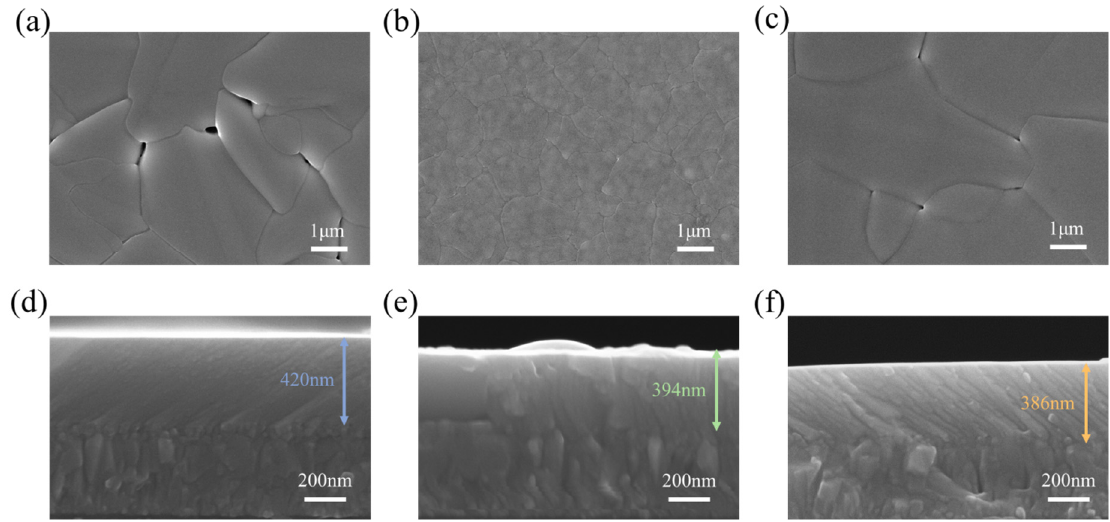
Figure 2. Top-view SEM images of the ( a ) Sb 2 S 3 , ( b ) Sb 2 (S, Se) 3 , and ( c ) Sb 2 S 3 /Sb 2 (S, Se) 3 films deposited on FTO/SnO 2 /CdS substrates. Corresponding cross-sectional SEM images of ( d ) Sb 2 S 3 , ( e ) Sb 2 (S, Se) 3 , and ( f ) Sb 2 S 3 /Sb 2 (S, Se) 3 films.